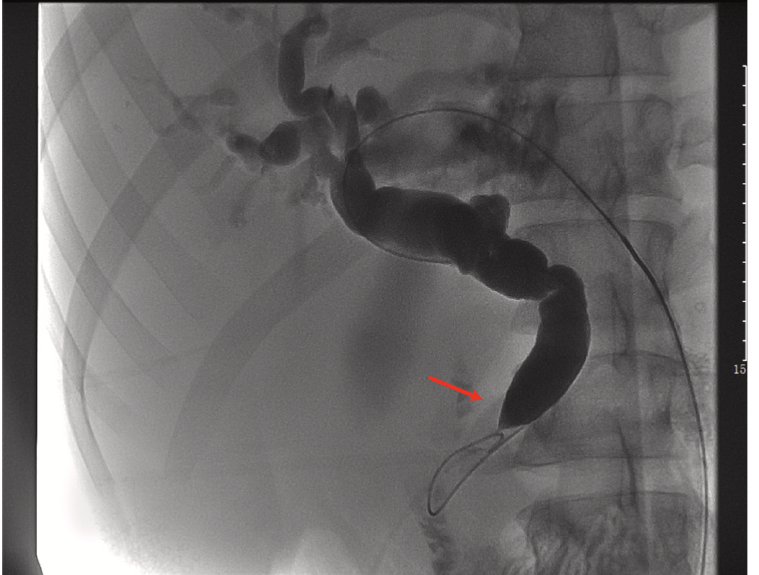
Figure 5. Preoperative PTCD. Imaging showing that the common bile duct (CBD) leading into the ampulla of Vater was compressed and obstructed, similar to a beak (red